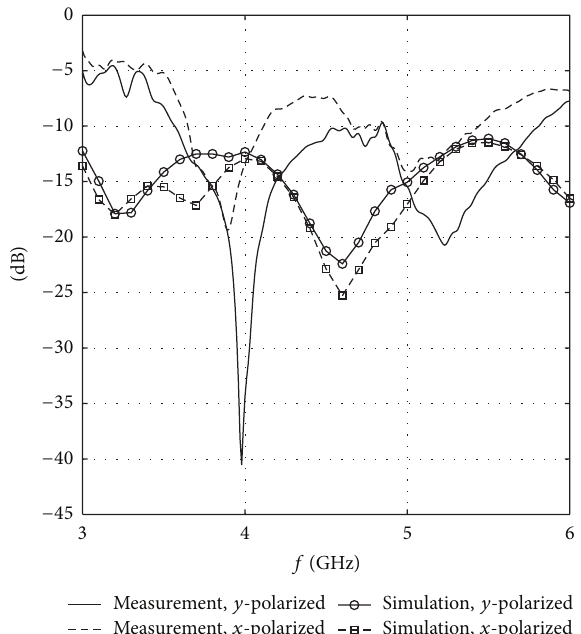
Figure 9: Experimental results of the normalized specular reflectance of the nonuniform surface sample with respect to both 𝑥 - and 𝑦 -polarized normally incident waves. The 𝑥 and 𝑦 directions are indicated by Figure